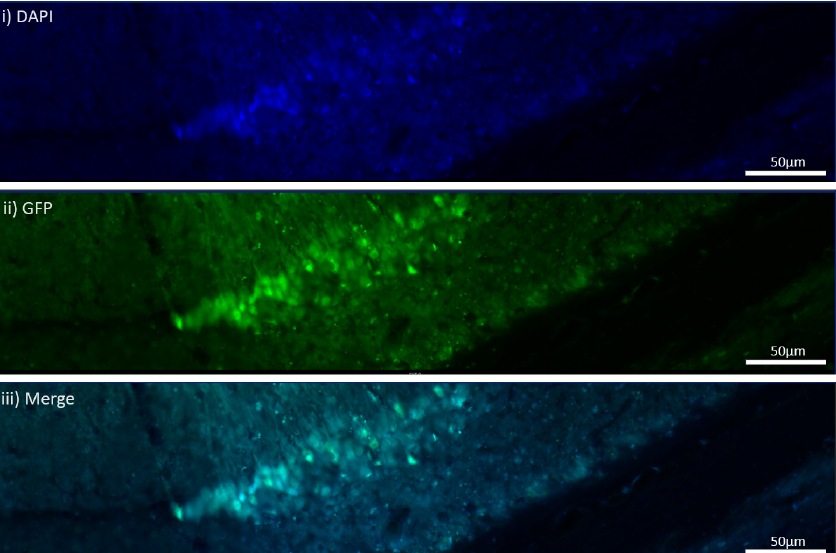
Figure 5. In vivo virus transduction of the hippocampal CA1 neurons in MEN1 floxed mice. ( i ) DAPI for nuclear staining; ( ii ) GFP expression in the CA1 neurons and the ectopic expression in the vicin- ity of the CA1 region as pointed by the arrows; ( iii ) merge showing the overlap between DAPI and GFP.